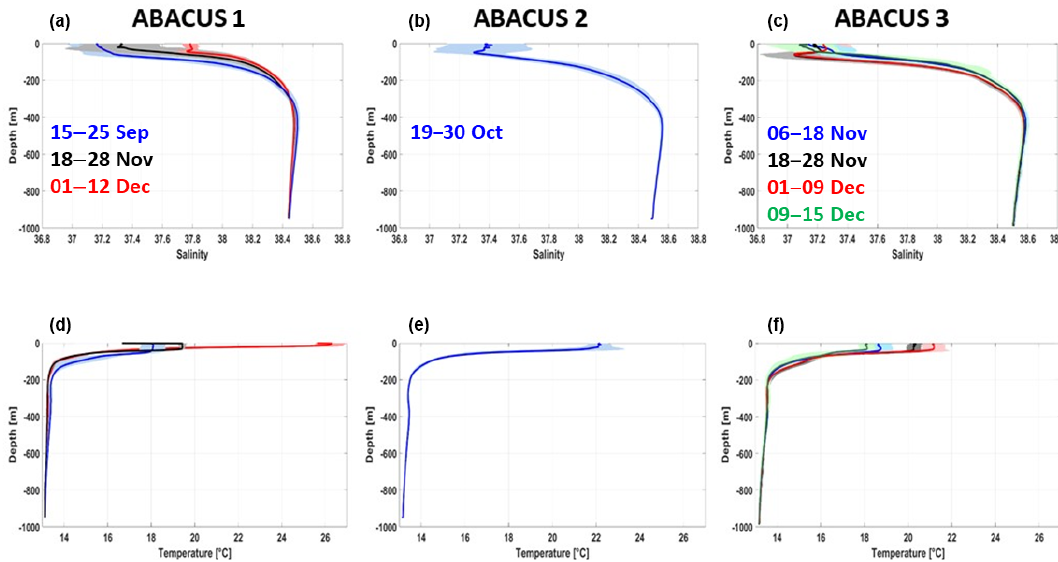
Figure 5. Mean salinity (a–c) and temperature (d–f) profiles (thick lines) for each ABACUS transect. From left to right, ABACUS 1, ABACUS 2 and ABACUS 3 data are represented. For each mission, the first available mean profile is shown in blue, the second in black, the third in red and the fourth in green. The shaded area represents the standard deviation calculated at each depth for each mean